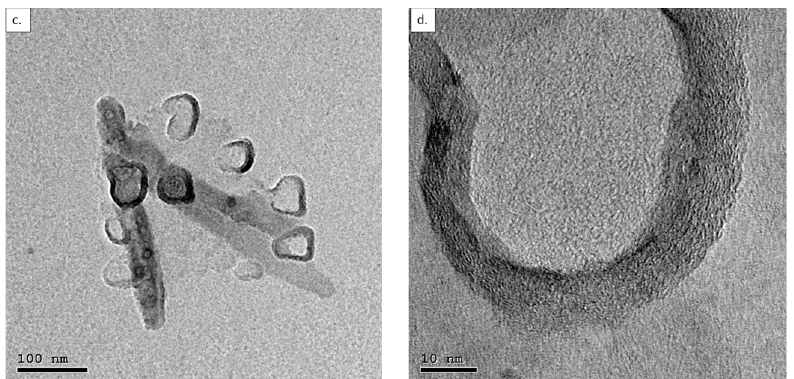
Figure 3. TEM of Eli-400 CNTs: ( a ) CNT agglomerate, ( b ) magnified part of the agglomerate to show the open cap, ( c ) damaged CNTs, and ( d ) magnified part of the damaged CNTs showing the graphene walls.